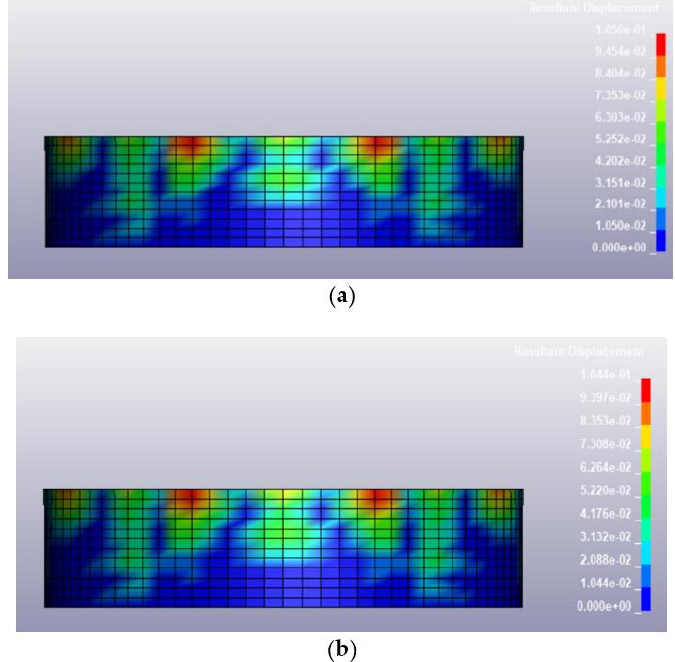
Figure 11. Deformed shape of the tank under blast intensity of 380 kg TNT equivalent mass 12.5 m away, ( a ) 100% fill level and ( b ) 0% fill level.